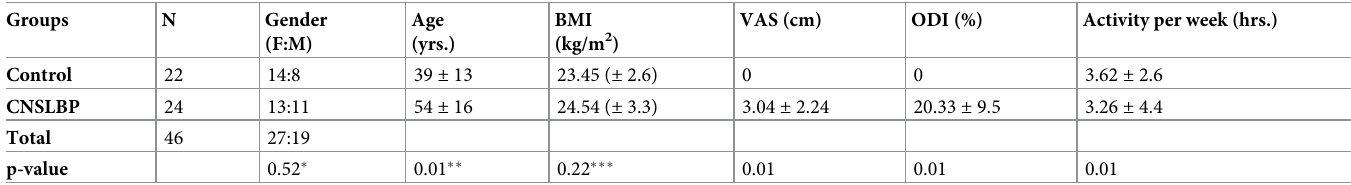
Table 2. Socio-demographic data of